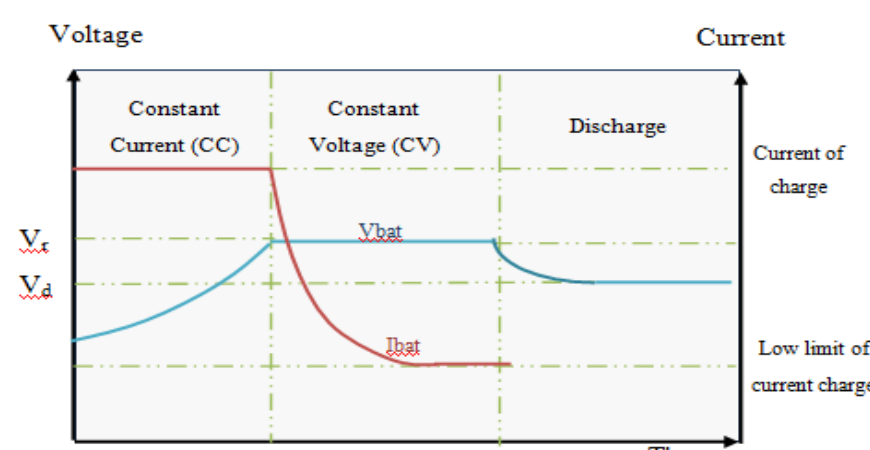
Figure 6. Control stages (CC/CV) of process